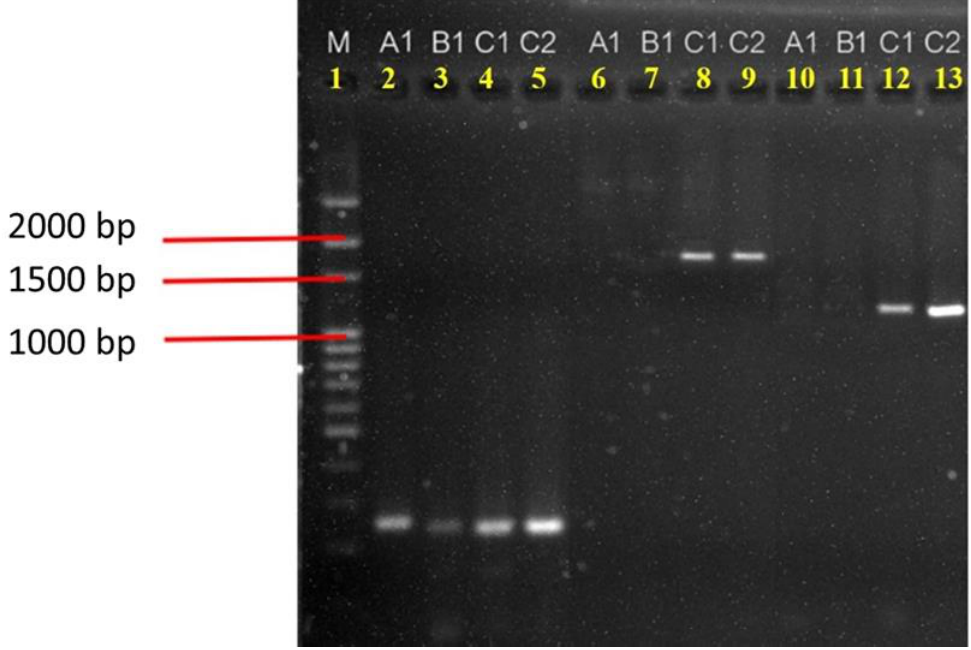
Figure 2. Amplification of Rf -linkage DNA marker in parental lines (A-line, B-line, and C-line). Lanes: 1 (100 bp DNA ladder), 2 to 5 (1.85 HRM marker (control)), 6 to 9 (3336-last2-SCAR marker), and 10 to 13 (4162-SCAR marker).